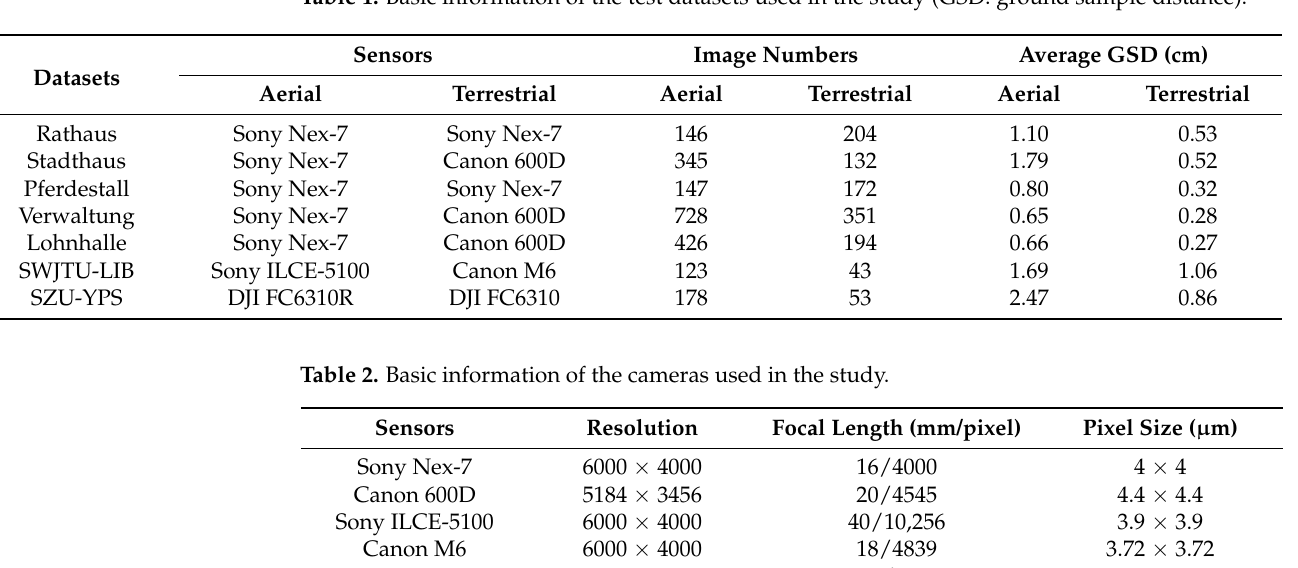
Table 1. Basic information of the test datasets used in the study (GSD: ground sample distance).